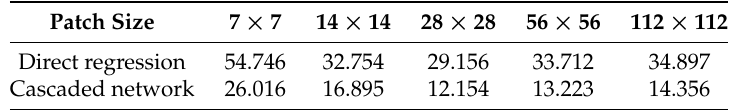
Table 6. The mean error on z-axis with respect to the patch size. (The unit of the values in table is mm.)